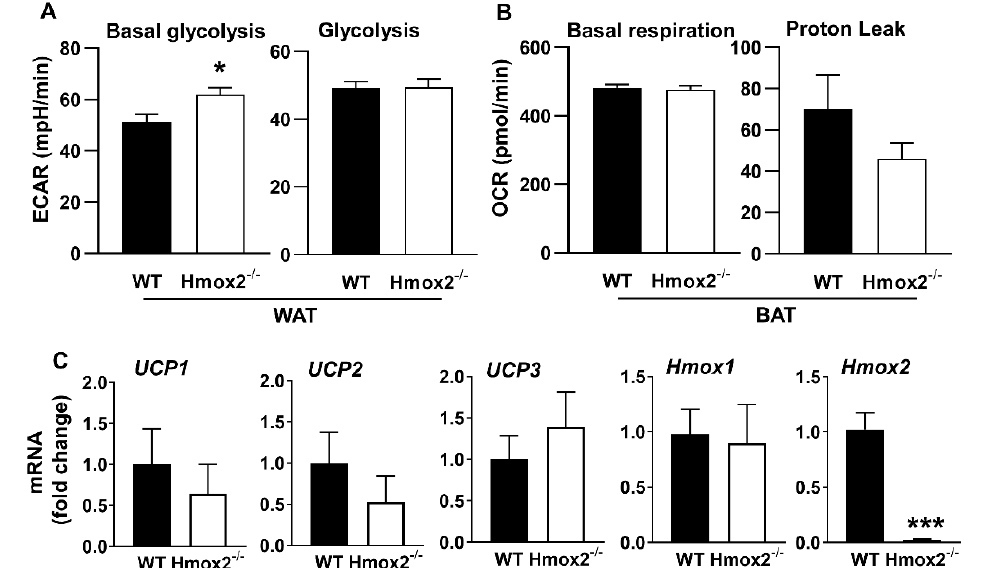
Figure 6. Glycolysis in gonadal WAT and mitochondrial respiration in interscapular brown adipose tissue (BAT) of Hmox2 - / - mice. Glycolysis ( A ) and mitochondrial oxidative phosphorylation ( B ) were measured using a Seahorse Analyzer in gonadal and interscapular fat pads, respectively, from Hmox2 - / - mice and WT littermates. ( C ) Uncoupling protein (UCP) 1 , UCP2, UCP3, Hmox1 , and Hmox2 gene expression were measured by qRT-PCR in gonadal WAT of WT and Hmox2 - / - mice. Data are expressed as mean ± SEM. n = 5–7. * p < 0.05, *** p < 0.001 vs. WT group.